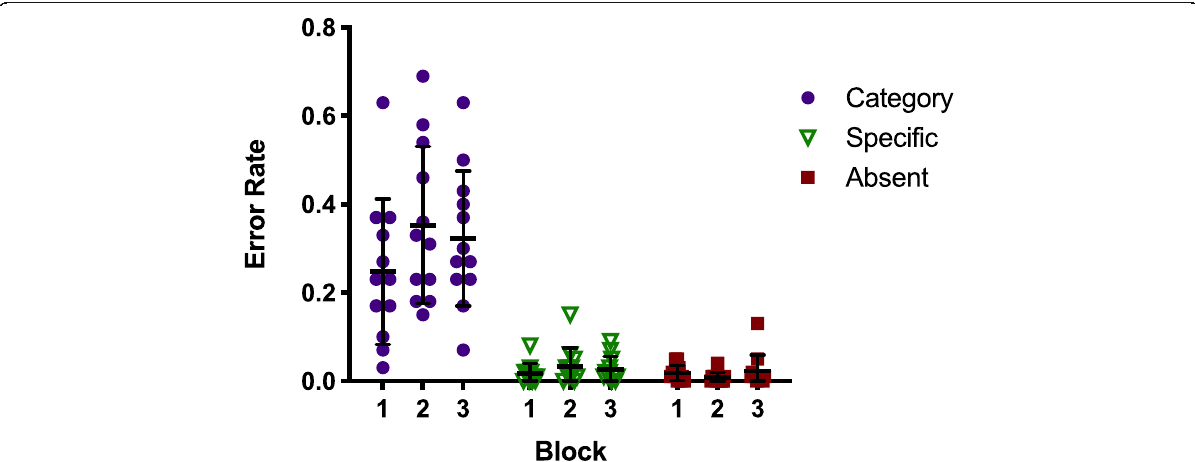
Fig. 3 Error rates for all search trials in Experiment 1a, as a proportion of trials of that type. Each dot represents the error rate for one observer. Error bars represent the standard